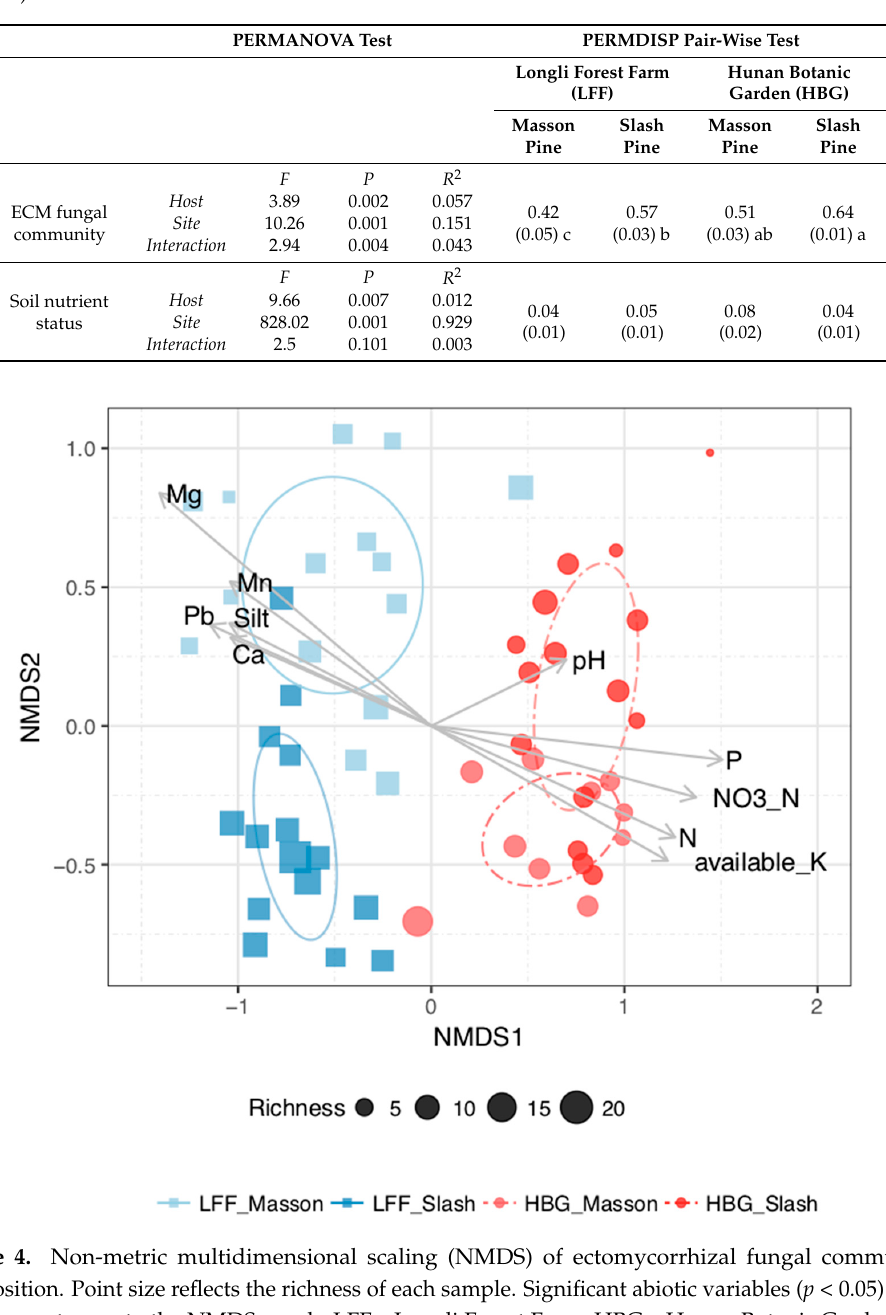
Table 3. PERMANOVA analyses performed to test the differences in ECM fungal community and soil properties among forest types. Post hoc PERMDISP pair-wise analysis tests were applied to data from all forest types across the sites. Values represent the site mean with standard error in parentheses. Different letters indicate significant differences among forest types based on Tukey HSD post-hoc test ( p < 0.05).